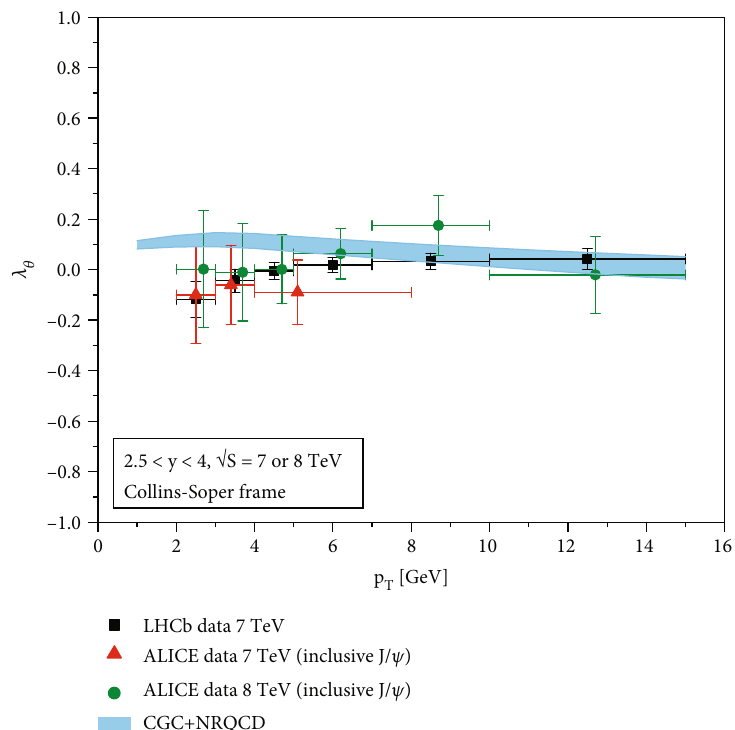
– 134]. Figure taken from